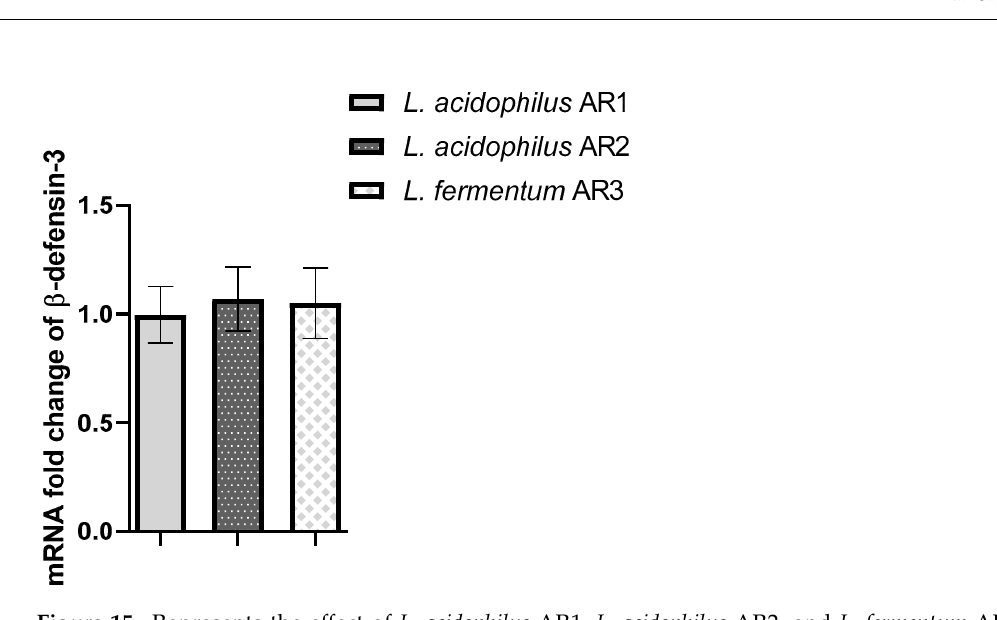
Figure 15. Represents the effect of L. acidophilus AR1, L. acidophilus AR2, and L. fermentum AR3 on beta-defensin 3 mRNA expression. No significant difference was observed with respect to the control (1).